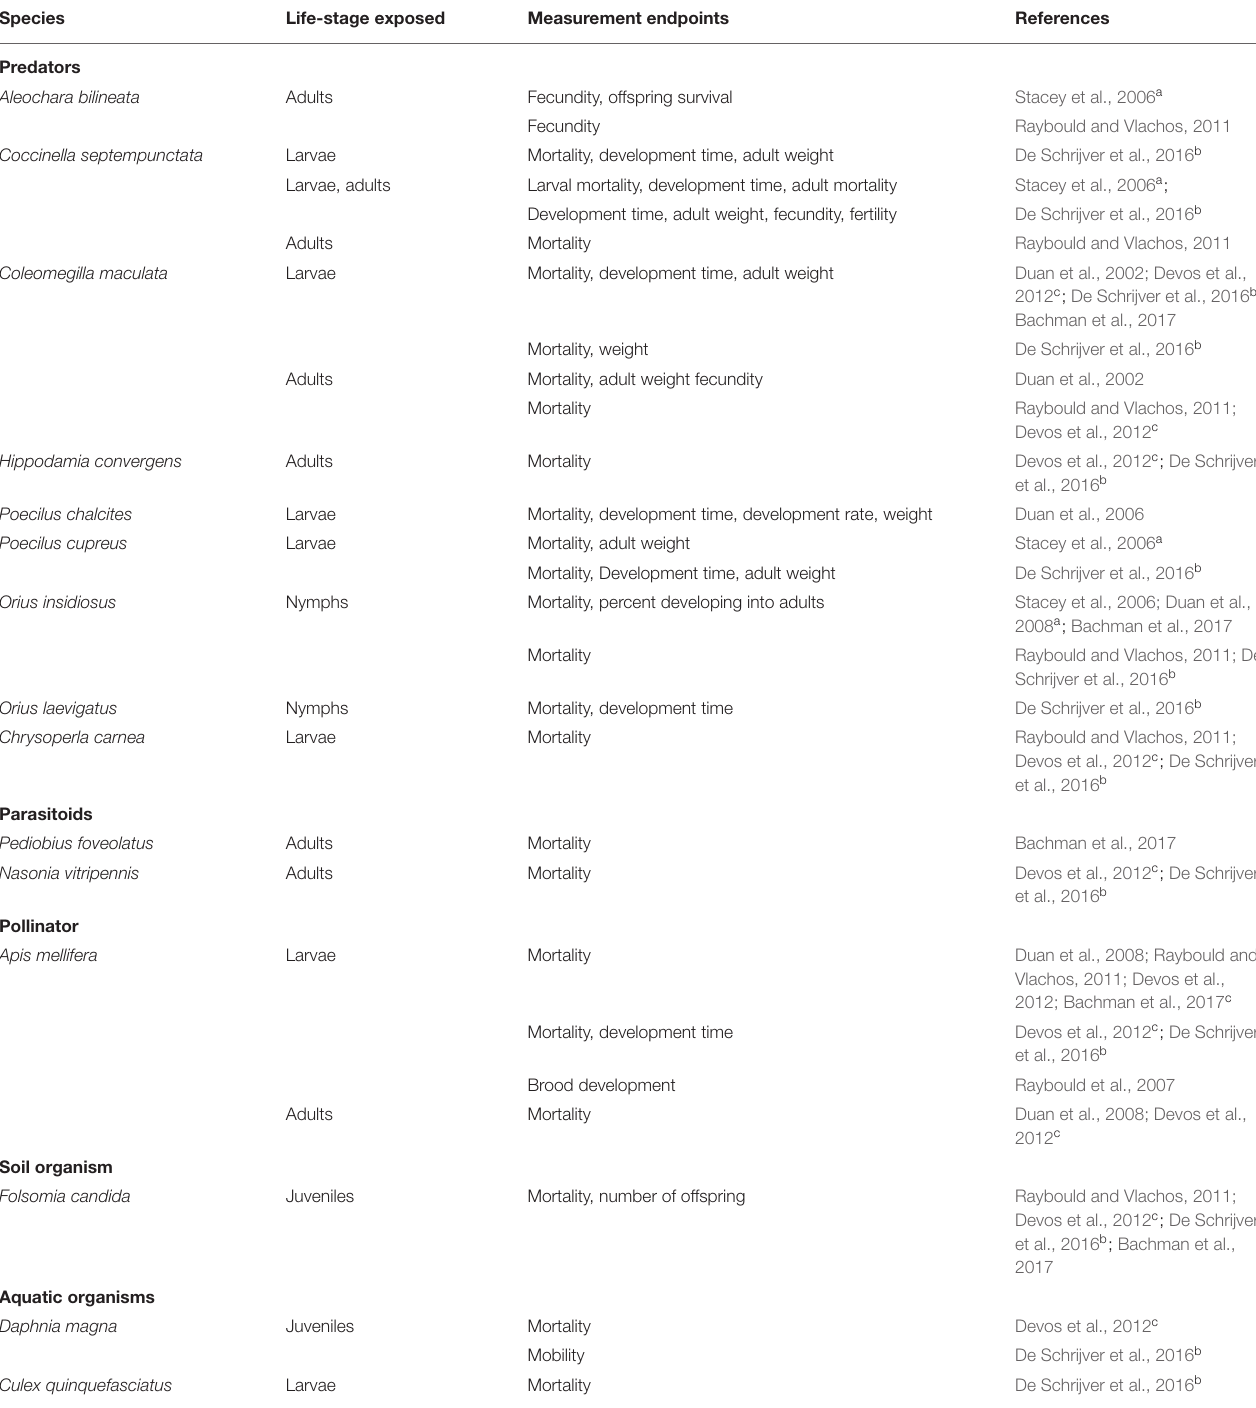
TABLE 1 | Laboratory studies with beneficial non-target invertebrates (predators, parasitoids, pollinators) or surrogate species for the soil and aquatic environment to support the regulatory risk assessments of plant expressed insecticidal Bt Cry